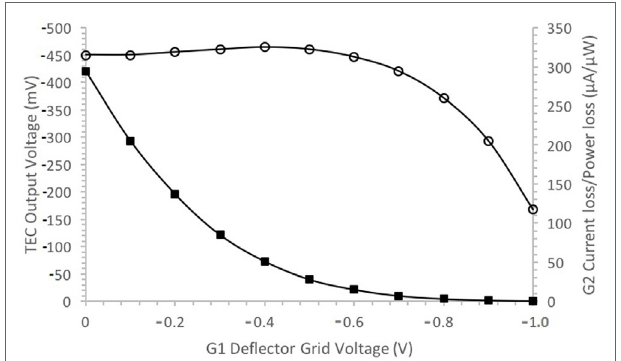
FigUre 2 | Results of the dual-grid Mk I thermionic energy convertor (TEC), measurement error 2% (open circles) TEC output voltage (mV) (filled squares) grid 2, current loss/power loss ( μ A/ μ W)—grid 2 is driven at 1 V therefore power and current losses are numerically equal. TEC output voltage is established with the grid 2 field, and power losses minimized using the grid 1 to inhibit current to grid